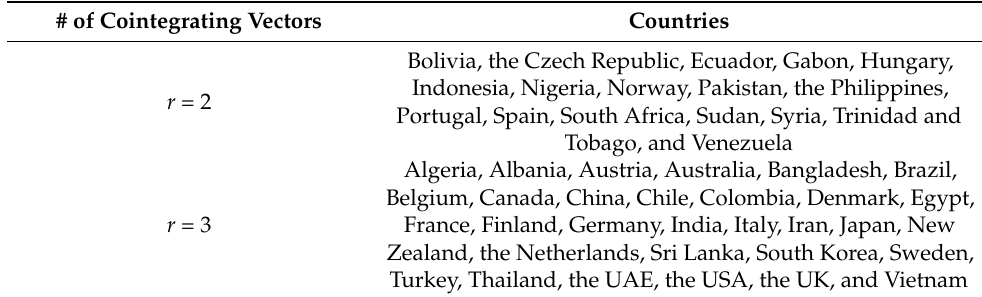
Table 1. Summary of cointegration test